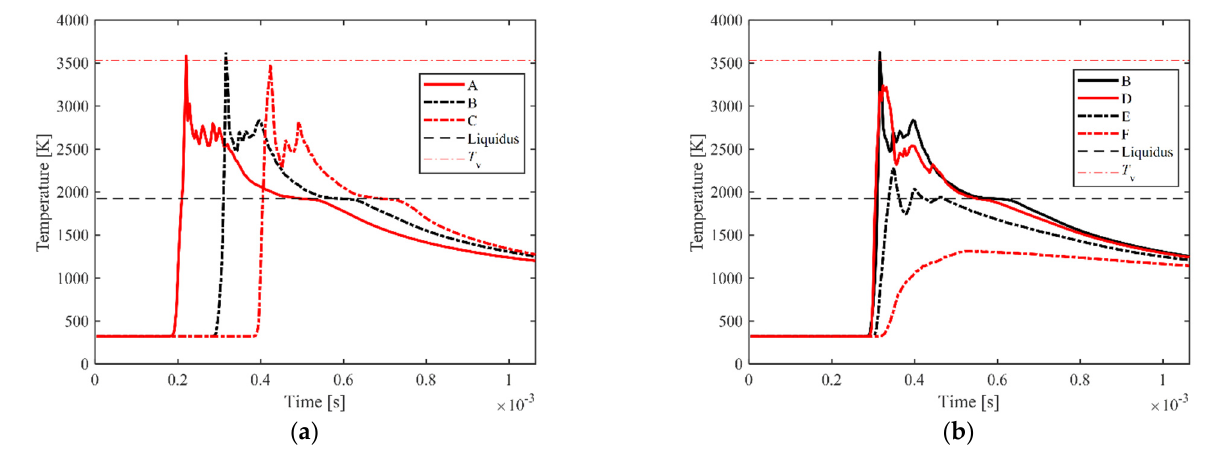
Figure 4. Temperature history of the characteristic points during the laser-scanning process, in which the positions of these points are shown in Figure 2f,l: ( a ) temperature history of the characteristic points along the scanning direction; ( b ) temperature history of the characteristic points vertical to the scanning direction.